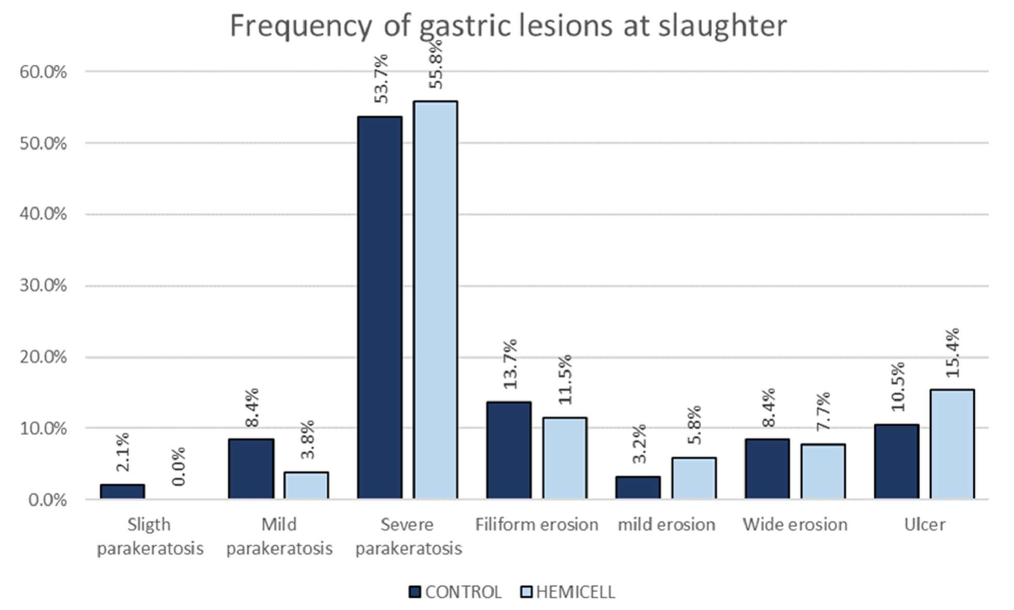
Figure 7. Frequency for each gastric lesional category at slaughter. There were no significant differ- ences in any of the categories between observed and expected frequencies.